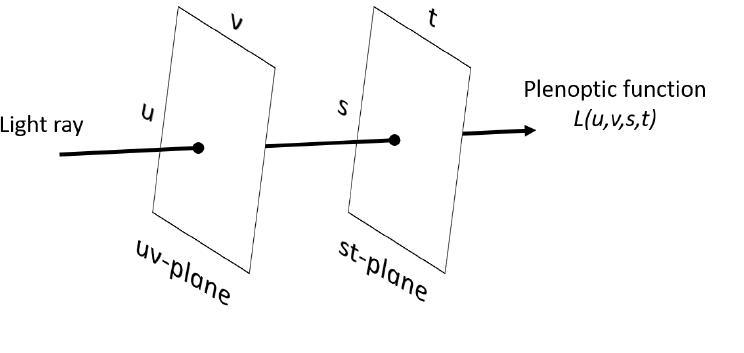
Figure 3. Schematic representation of the plenoptic function [18].